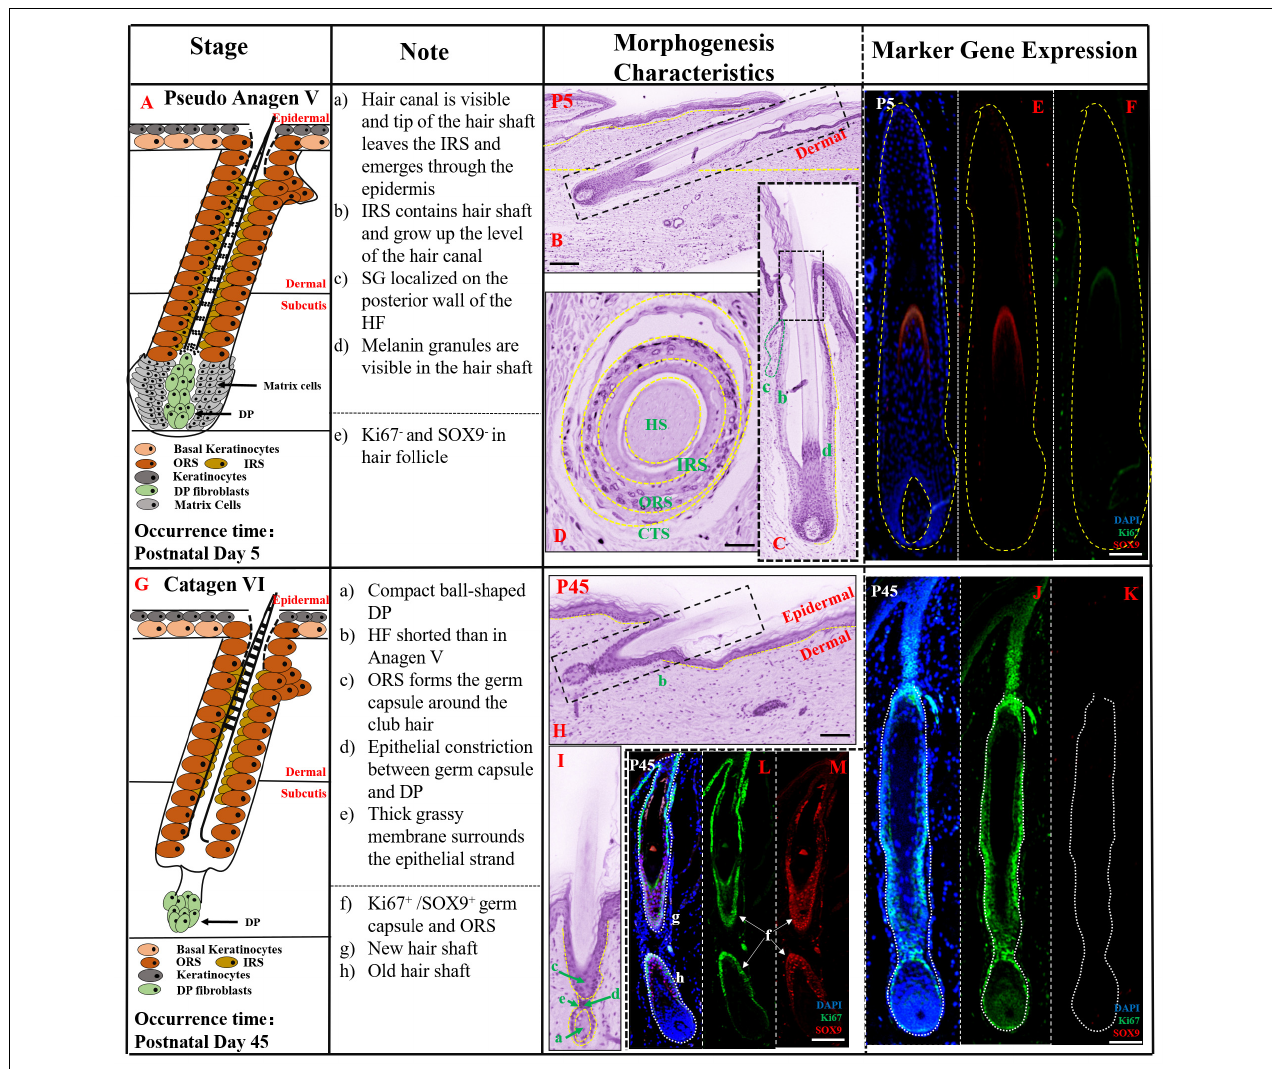
FIGURE 4 | The prenatal hair follicle morphogenesis development maintained until postnatal P45. (A,G) A schematic diagram of HF morphogenesis development in the postnatal stage (P5–P45). The Note column summarizes simple basic parameters for HF staging by H&E staining (above dotted line) and marker gene expression (below dotted line). (B) The characteristics of pig hair follicle morphology at P5 by H&E. (C) Partial enlarged detail of hair follicle in part (B) . The characteristics of pig hair follicle morphology in transverse section at P5 (D) and P45 (H) by HE; (E) SOX9 expression in hair shaft at P5 by IF; (F) Ki67 expression in proliferation keratinocyte cells at P5 by IF; (I) Partial enlarged detail of hair follicle in part (H) . (J,L) Ki67 expression in pig proliferation keratinocytes cells at P45 by IF. (K,M) Sox9 expression in pig hair follicle at P45 by IF. Scale bars: 50